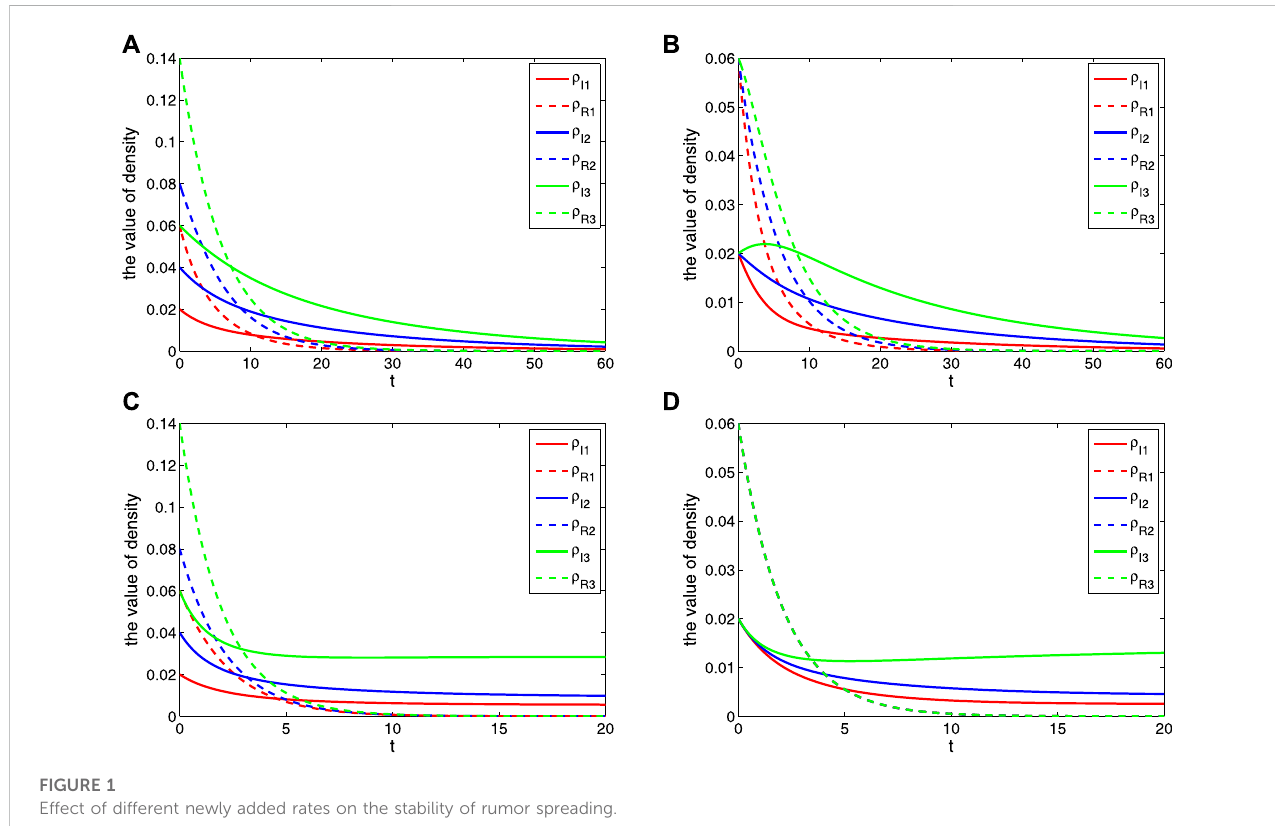
FIGURE 1 Effect of different newly added rates on the stability of rumor